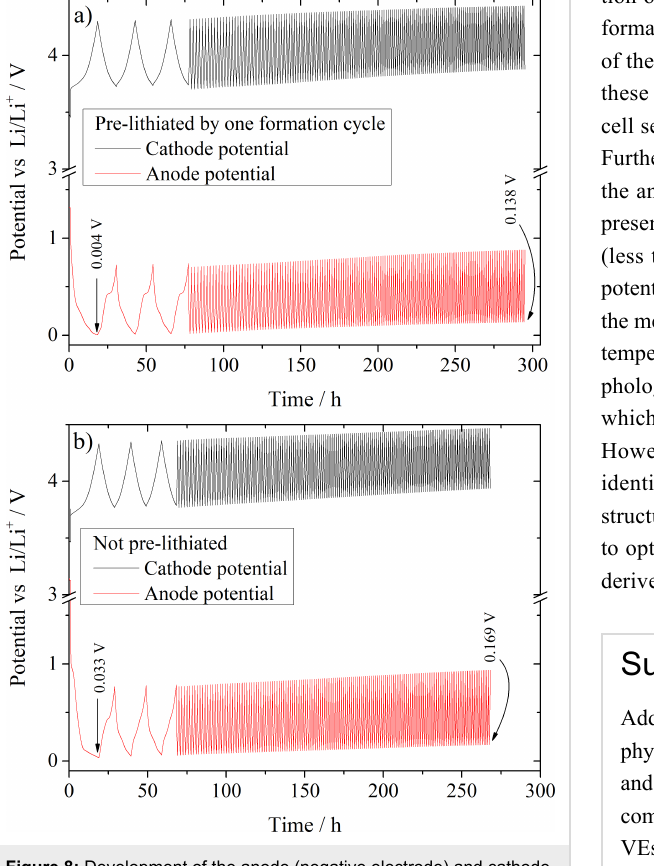
Figure 8: Development of the anode (negative electrode) and cathode (positive electrode) potential vs Li/Li + in dependence of the time during cycling using a LIB full cell set-up with a prelithiated (a) and a non- prelithiated (b) C:Si 90:10 composite anode vs a NMC-111 cathode. RE: metallic lithium, cut-off voltages: 3.0 V and 4.3